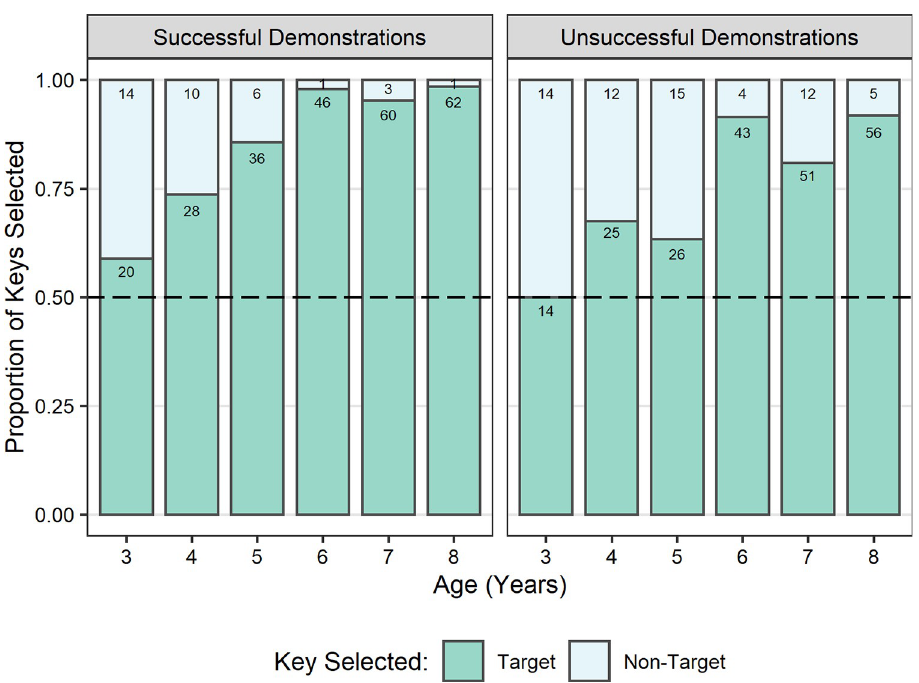
Fig 5. Proportion of target and non-target key selections by age in years. Includes only trials in which participants who watched the target demonstration video ( N = 564). Target key selections equate to appropriate information use. After successful demonstrations, the appropriate response was to copy the demonstrator’s key selection; after unsuccessful demonstrations, the appropriate response was to avoid copying the demonstrator’s selection. Values presented on bars refer to the number of trials each proportion represents. Dashed line indicates